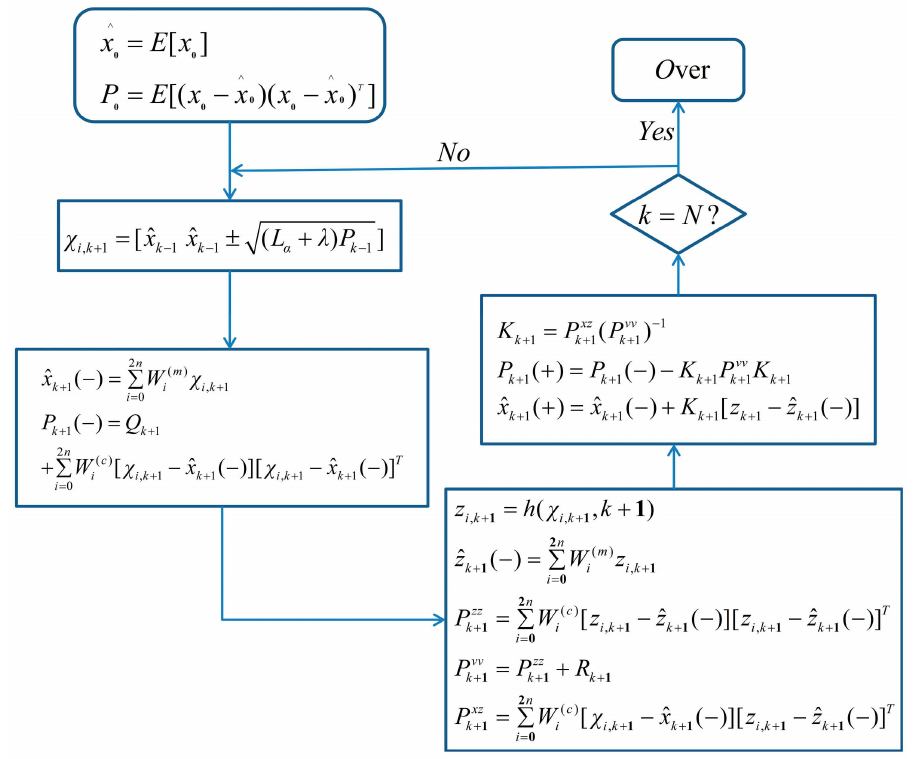
Figure 9. UKF estimation process.